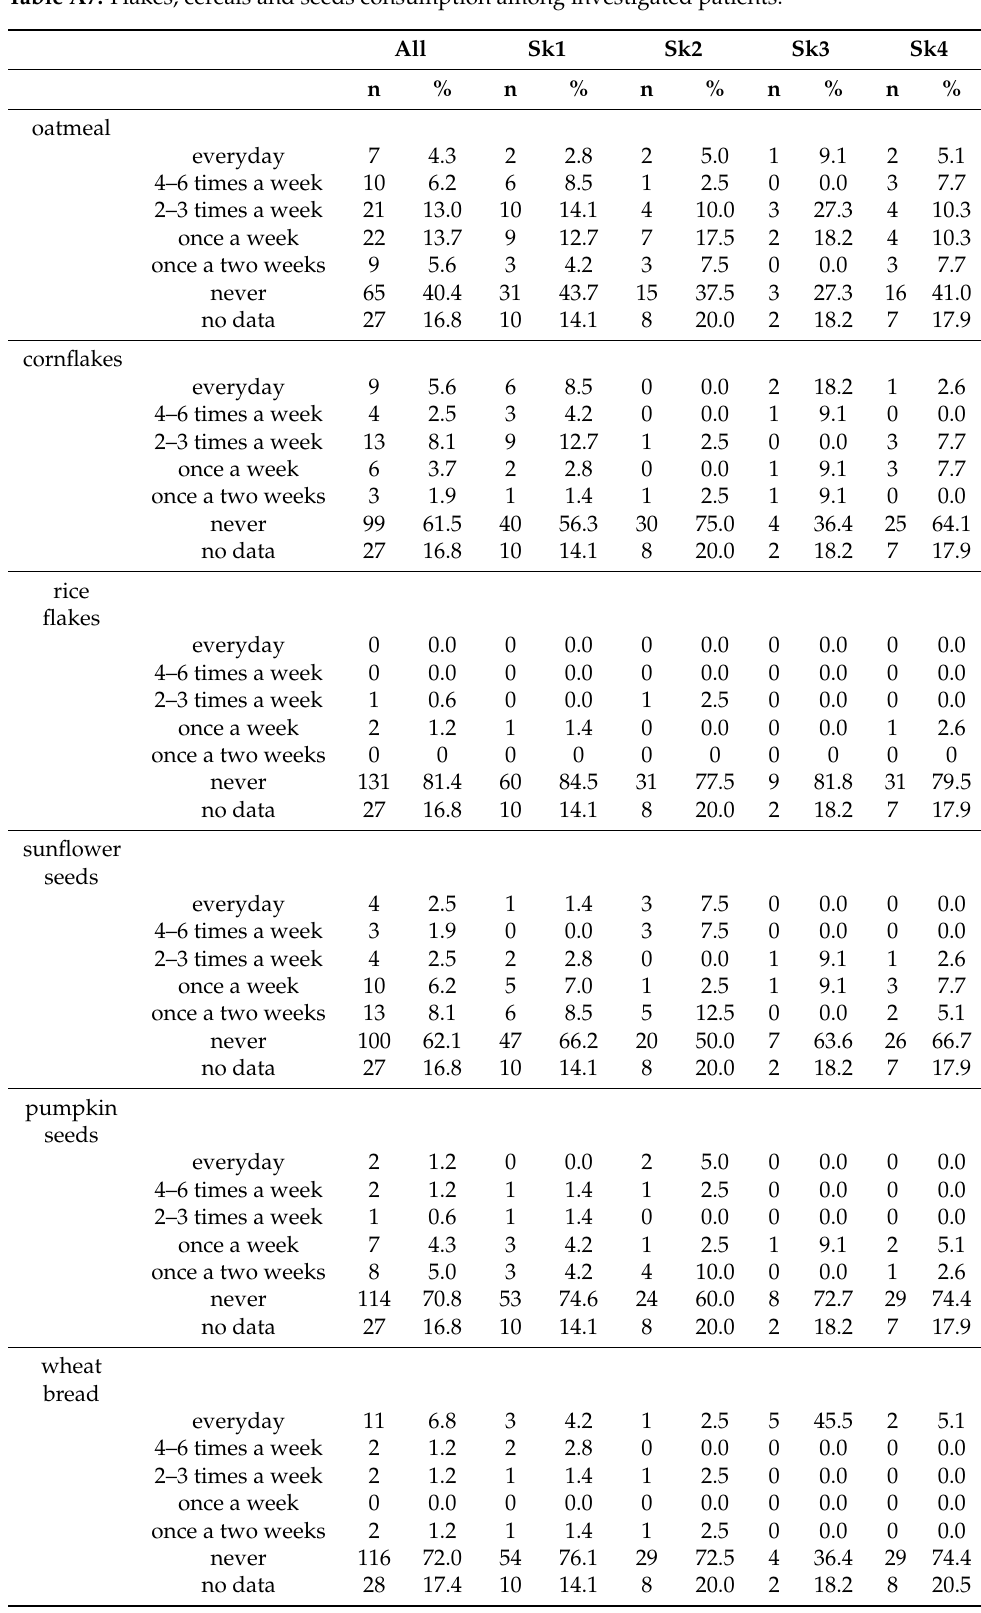
Table A7. Flakes, cereals and seeds consumption among investigated